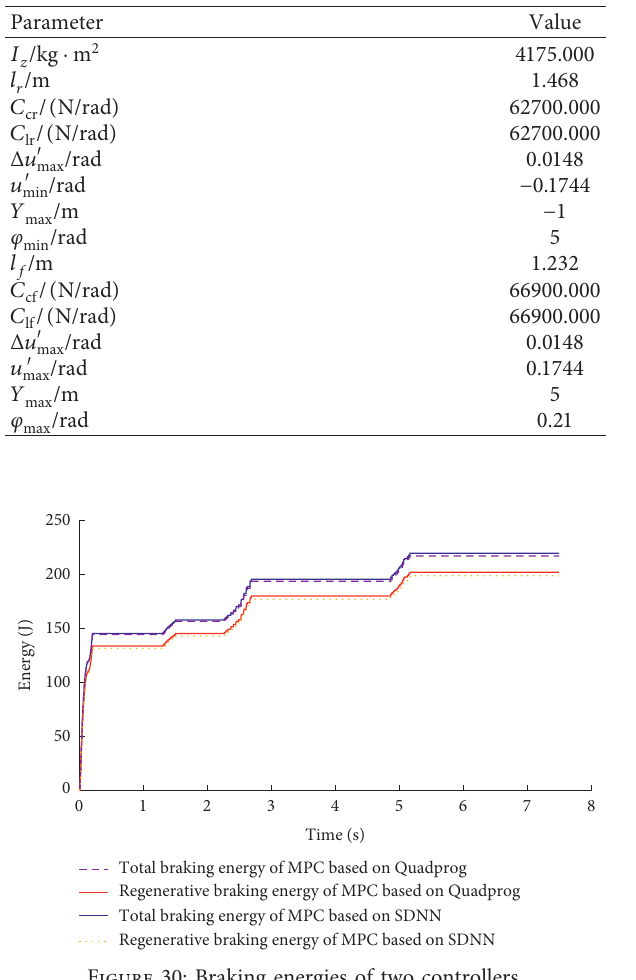
Table 16: Values of the parameters in the lateral dynamics con- troller design.